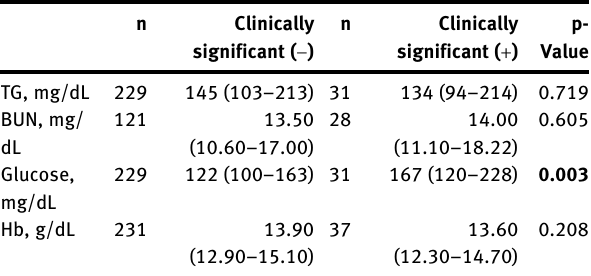
Table  : Comparison of TG, BUN, glucose and Hb levels of the groups with and without clinically signi fi cant difference for HbA 